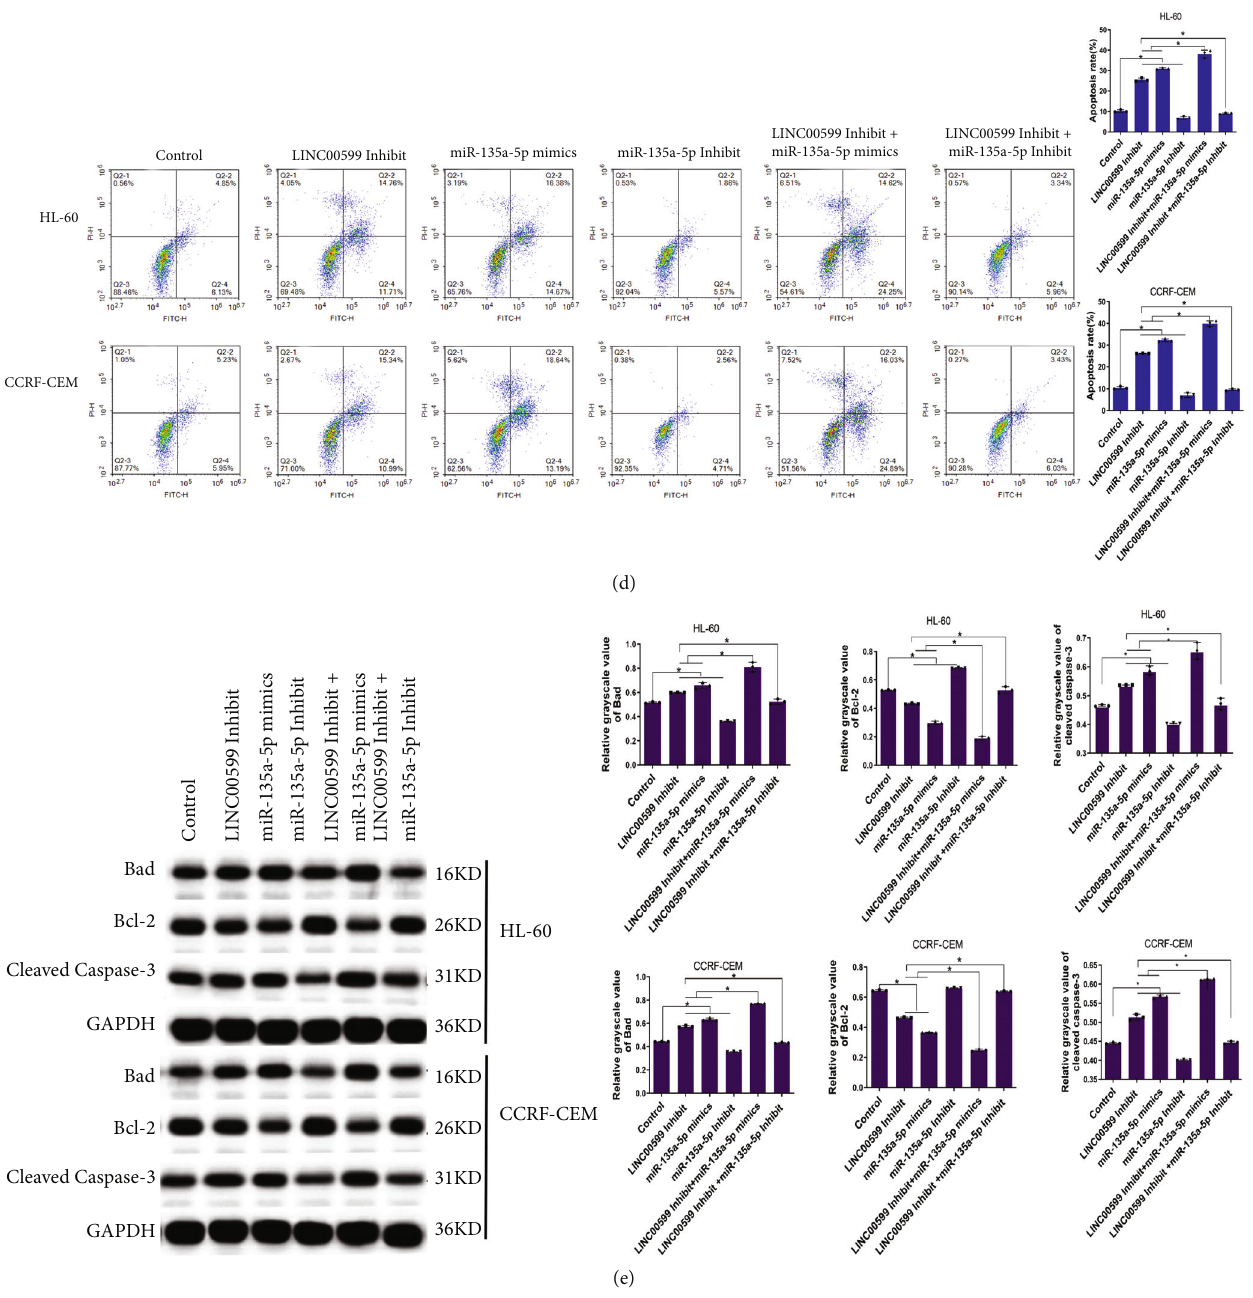
Figure 4: E ff ect of LINC00599-miR-135a-5p interaction on apoptosis. (a) qPCR determining vector e ffi ciency. (b) Transfection e ffi ciency evaluation by detecting luciferase activity. (c) CCK8 assay revealing the proliferation of each group of cells. (d) Flow cytometric analysis for detecting apoptosis in each group of cells. (e) Western blotting analysis for the detection of apoptosis-related proteins in each group of